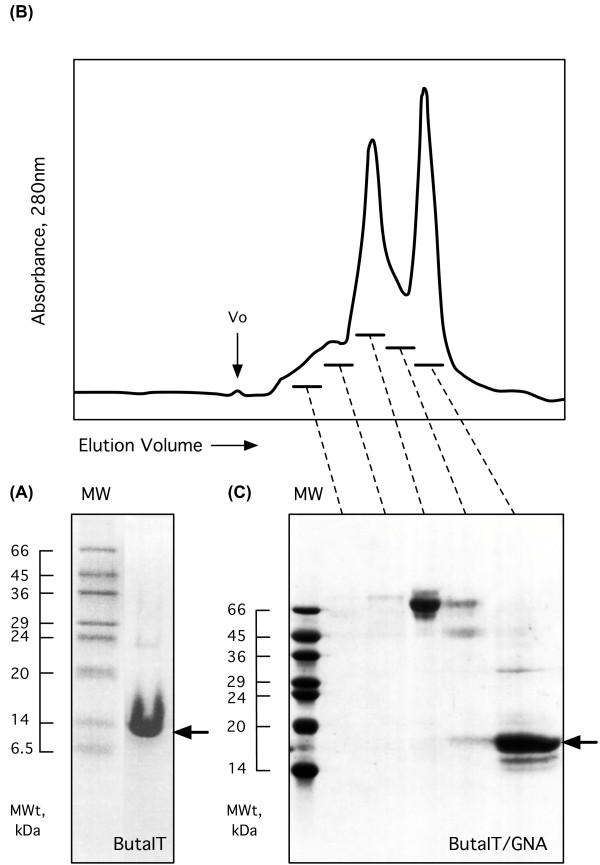
Production of recombinant proteins. (A). Analysis of partially purified ButaIT by SDS-PAGE (Tris-Tricine buffer system); gel stained with Coomassie blue. Arrow indicates ButaIT polypeptide, based on reaction with anti-(his)6 antibodies on Western blot. (B), (C). Purification of ButaIT/GNA by gel filtration. Following partial purification by phenyl-Sepharose chromatography recombinant proteins were loaded onto a Sephacryl S200 column equilibrated in PBS buffer. (B) absorbance profile and (C) corresponding fractions run on SDS-PAGE (15 % acrylamide gel, stained with Coomassie blue). The arrow depicts purified ButaIT/GNA.